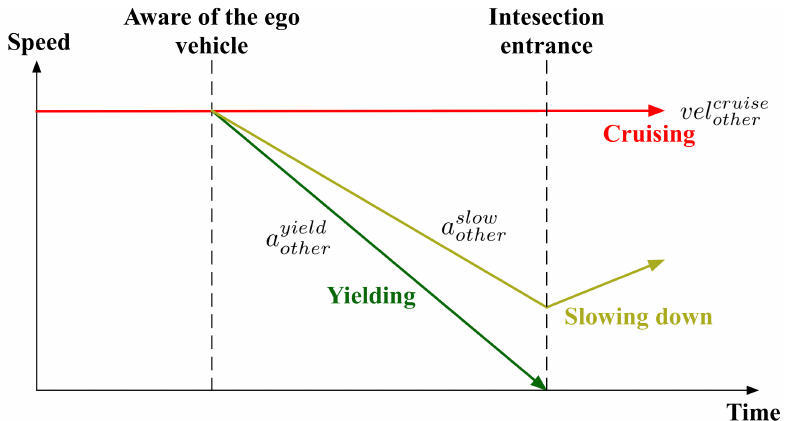
Figure 11. Speed profiles of three possible behaviors in the proposed behavior model for vehicles approaching blind